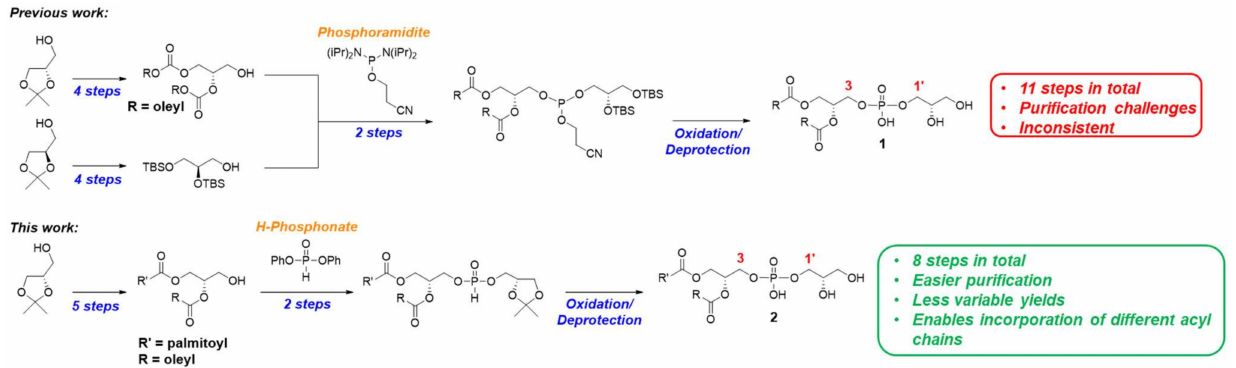
Figure 2. PG was previously synthesized using phosphoramidite methodology ( top ). A more efficient route was developed by incorporating H-phosphonates as the phosphonylating agent ( bottom